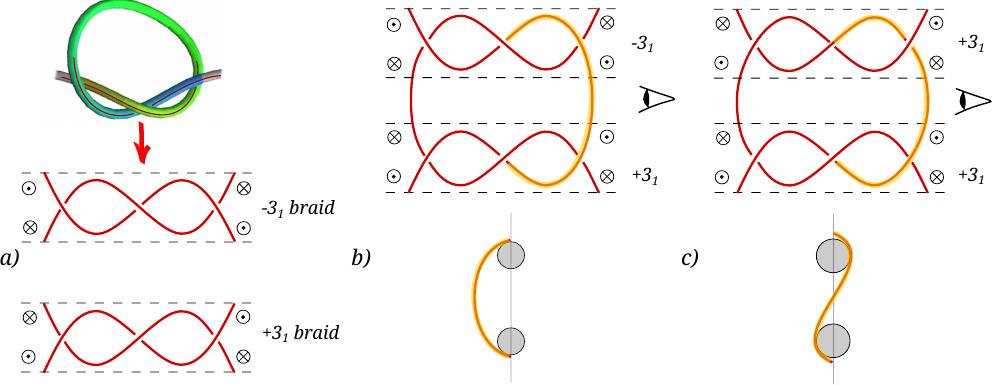
Figure 10. ( a ) A trefoil knot can be decomposed into two loops and a braid. The two enantiomers are defined by the braid. The circles indicate the orthogonal components of the bending force vector. Following the usual conventions, crossed circles indicate chain directors going into the page, while dotted circles indicate chain directors coming out of the page; ( b , c ): Composing the intertwined knots of equal and/or different chiralities. In an intertwined ( + − ) knot ( b ), the director joins the junction between the braid and the loop in the same sense, while in an intertwined ( ++ ) knot ( c ), it points in opposite sense at the two junctions; ( b , c ) bottom: Schematic representation of the axial projection (in the direction of the braid axes, assumed to coincide) for the ( + − ) and ( ++ ) composite knots,